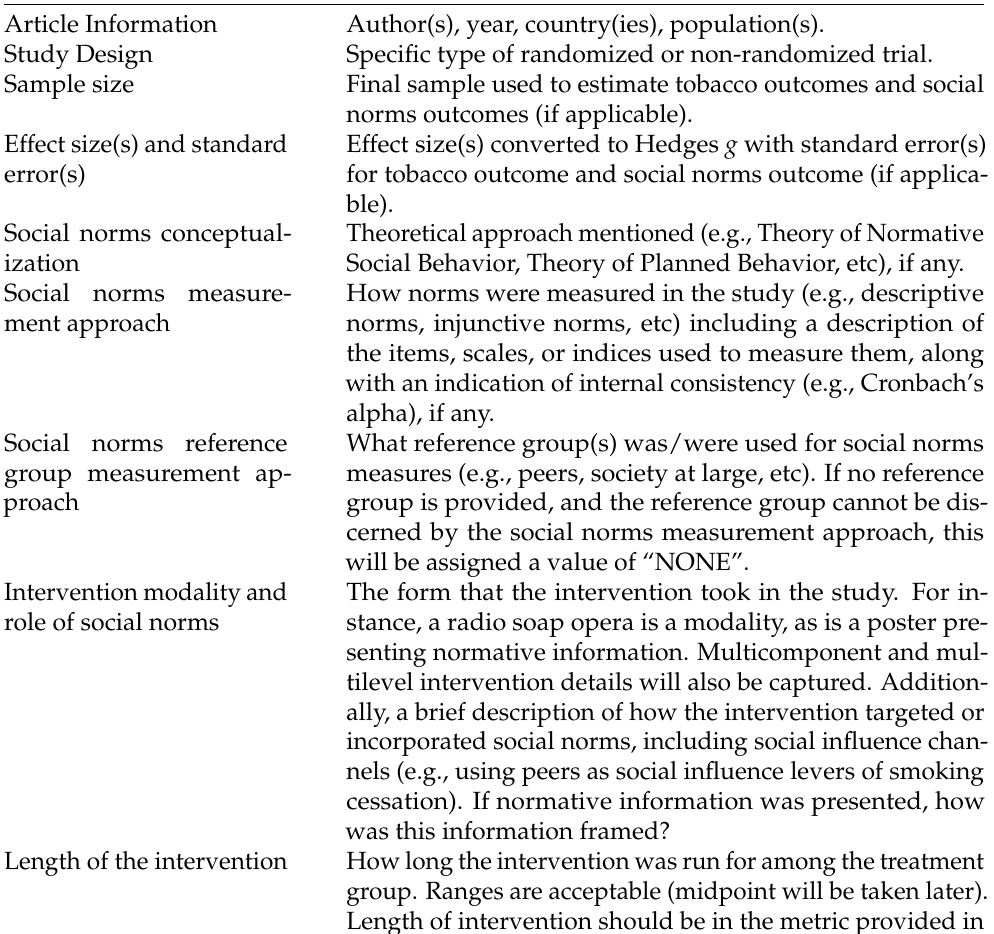
Table 1. The list of variables to be extracted and their